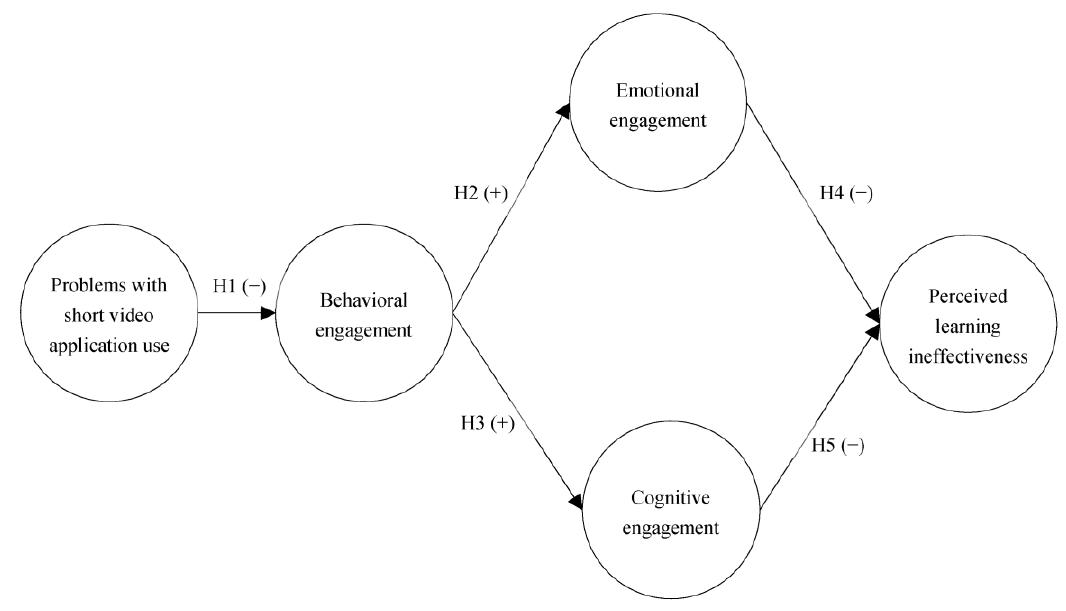
Figure 1. Research model.